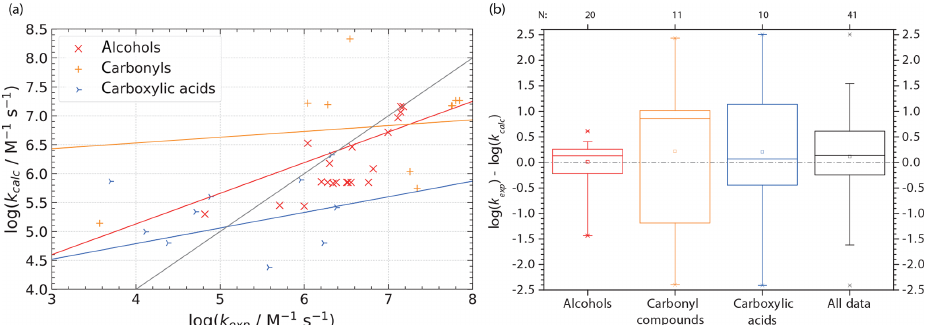
Figure 4. Evaluation of predicted versus experimental data for Evans–Polanyi-type correlations of NO 3 radical reactions with organic compounds using scatter plots (a) and analysis of absolute errors (b) distinguished by compound class. Parameters for the linear regression lines are given in Table S9 in the ESM.